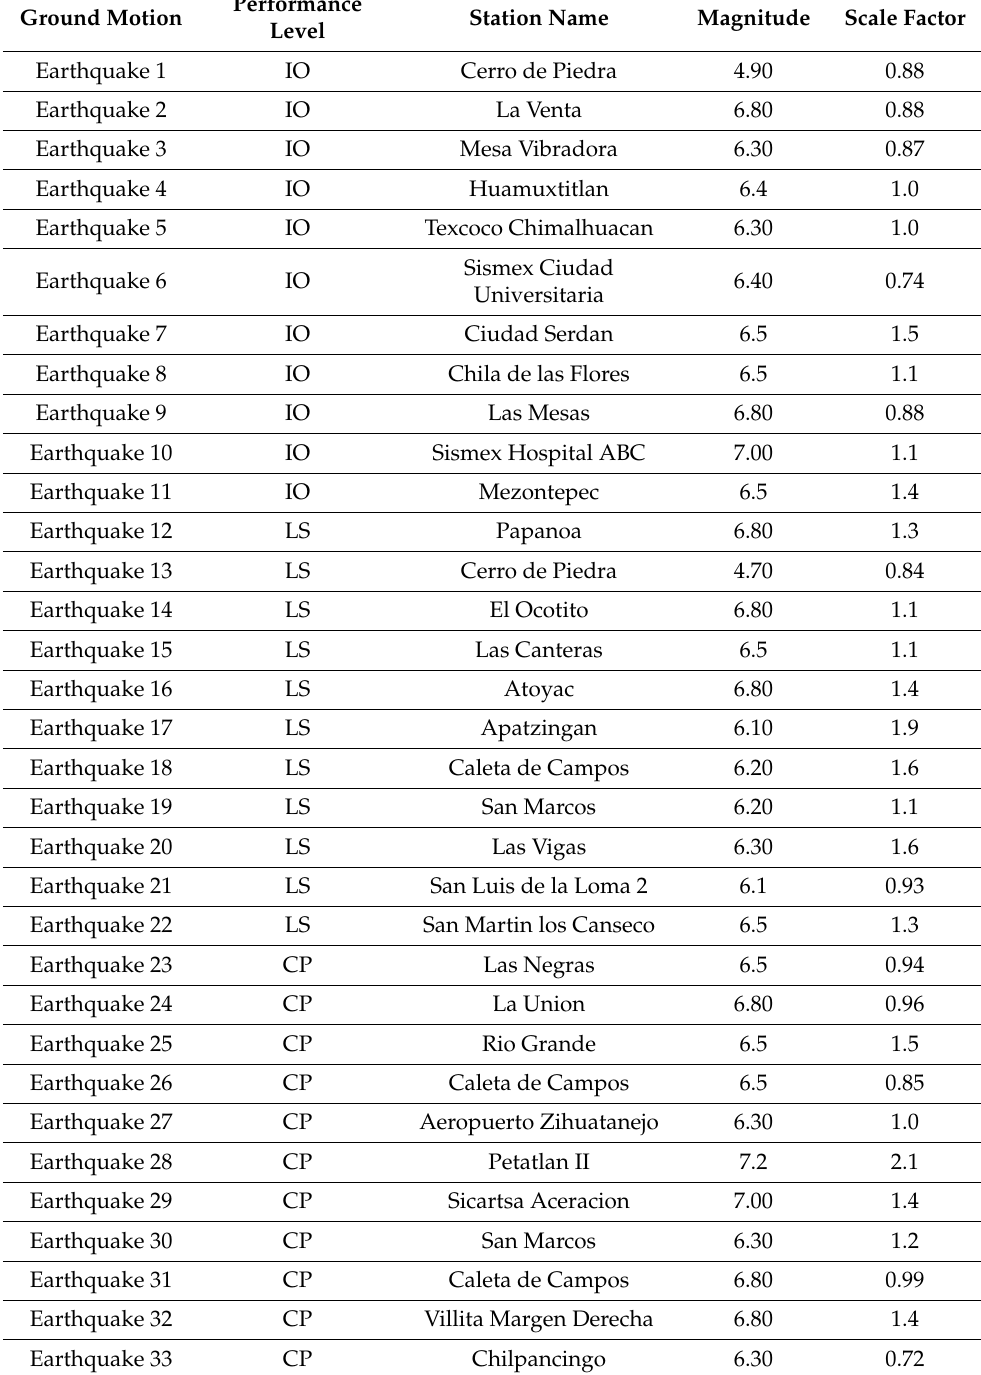
Table 4. Relevant information of selected ground motions for Agua Prieta, Sonora, corresponding to the reinforced concrete